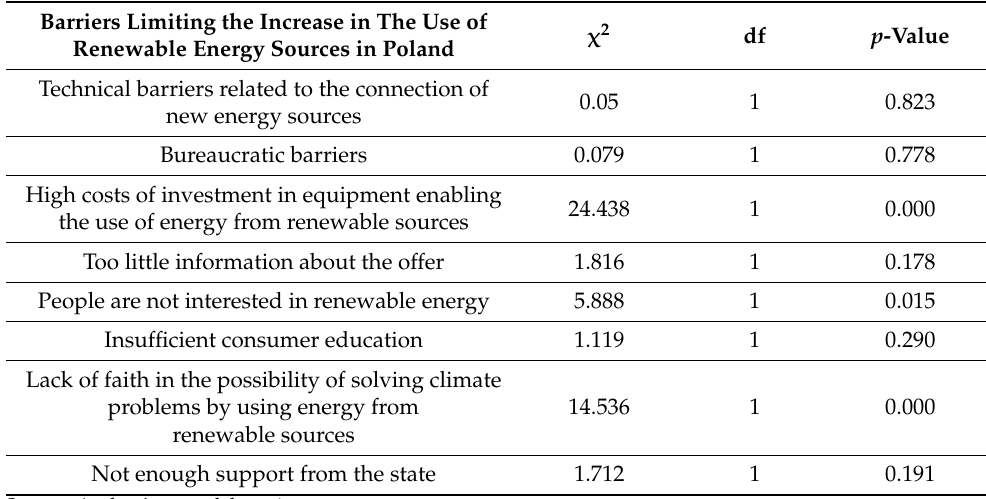
Table 4. Perception of barriers limiting the increase in the use of renewable energy sources in Poland and the use of renewable energy sources other than photovoltaic